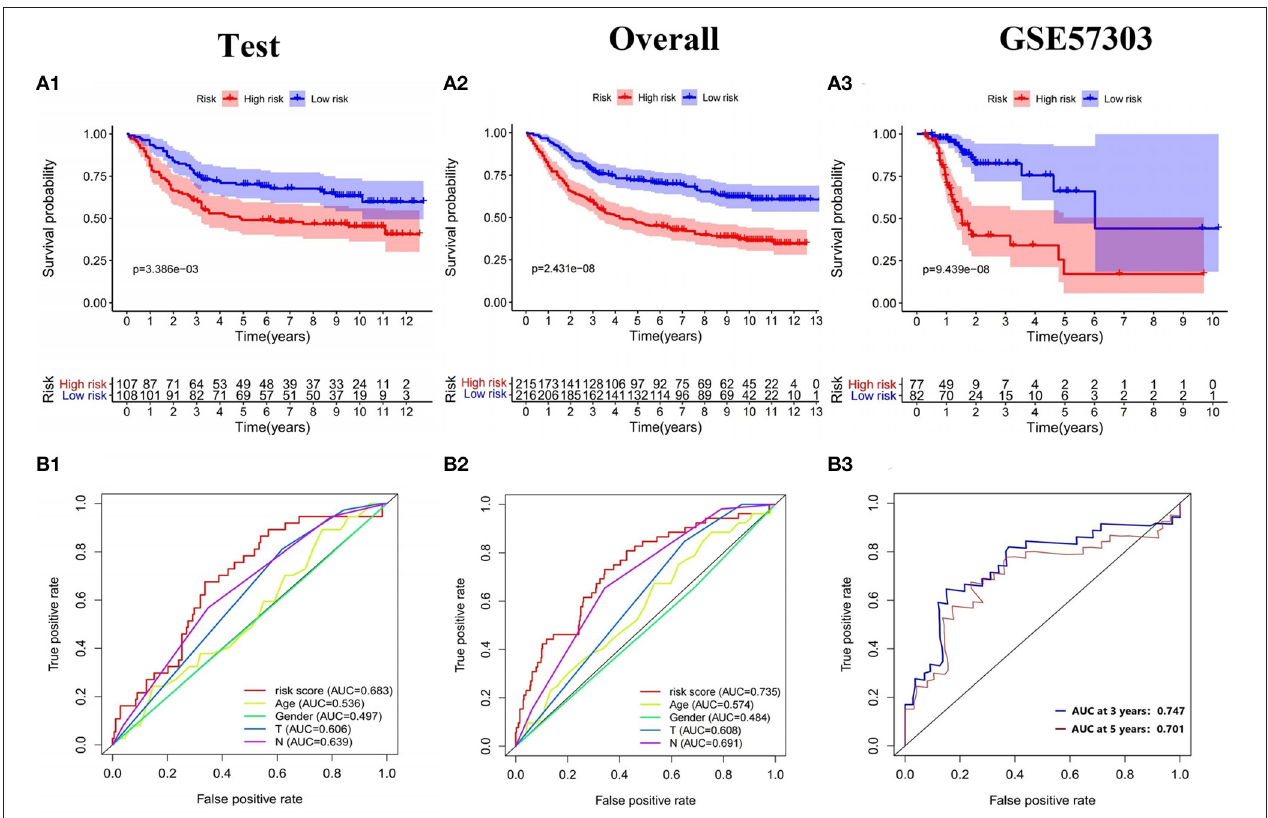
FIGURE 7 | Validation of the prognostic model. (A1–A3) K-M survival analysis and (B1–B3) ROC curve of the test set, the overall internal validation set and GSE57303 external validation set.